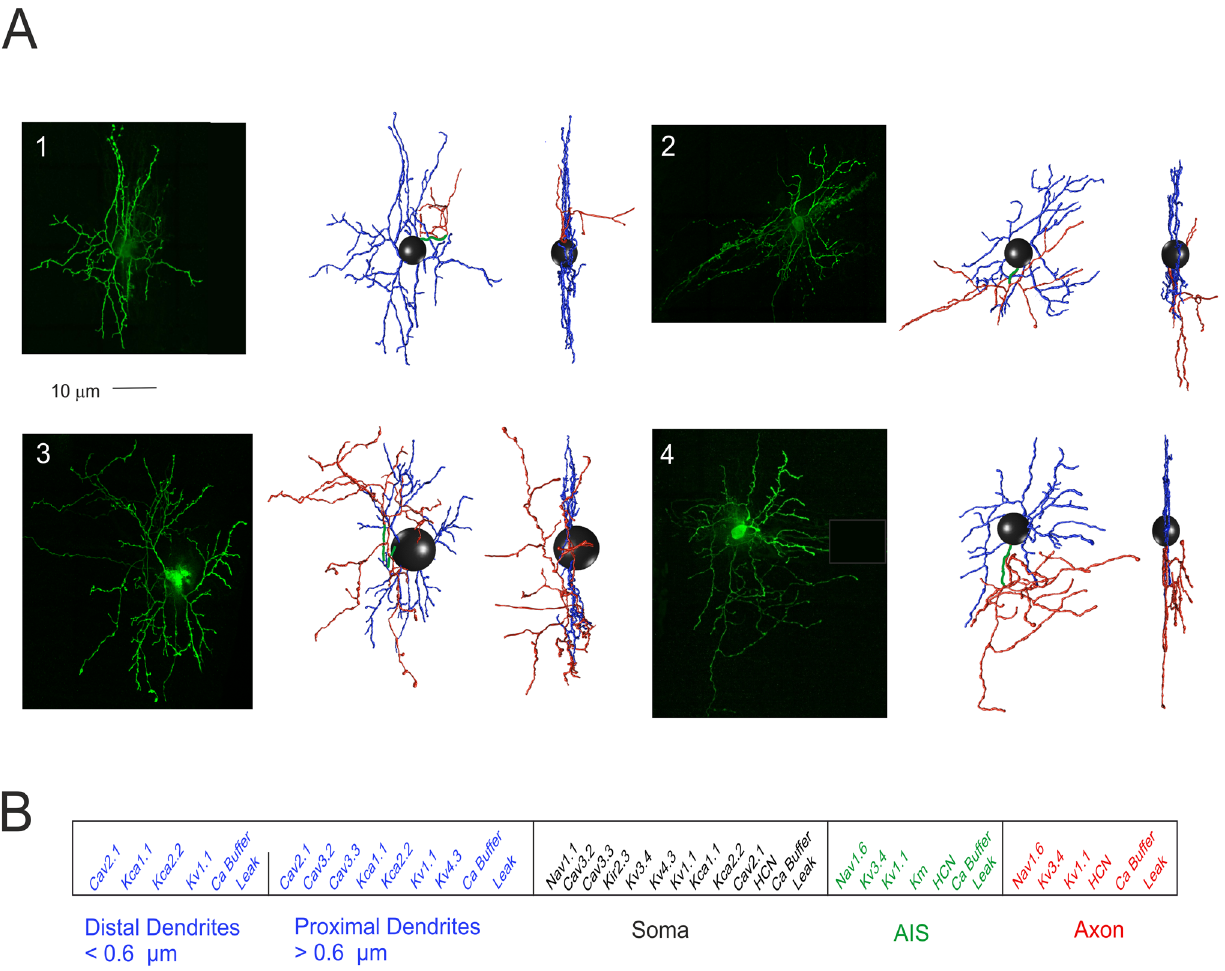
Figure 1. Stellate cell morphological reconstruction. (A) Confocal microscopy imaging of four mouse SCs filled with Lucifer yellow (scale bar 10 μm) are shown along with the corresponding digital reconstruction with Neurolucida (visualization with Vaa3D simulator; right). The 3D morphological reconstructions of SCs include dendrites (blue), soma (black), AIS (green) and axon (red). (B) The SC model is divided into five electrotonic compartments and endowed with specific ionic mechanisms according to immunohistochemical data. The proximal and distal dendrites are distinguished at the cut-off diameter of 0.6 µm. Ionic channels include Na + , K + and Ca 2+ channels and a Ca 2+ buffering